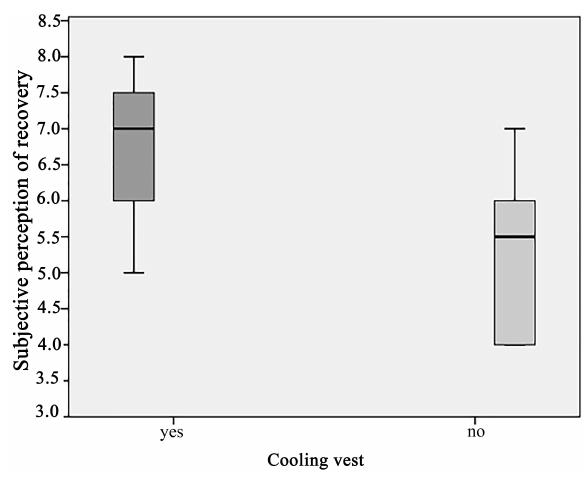
Fig. 6. Athlete’s subjective perception of recovery before the 500 m test. Mean ± SD with vest (6.85 ± 0.94) and without vest (5.25 ± 1.09) during the active